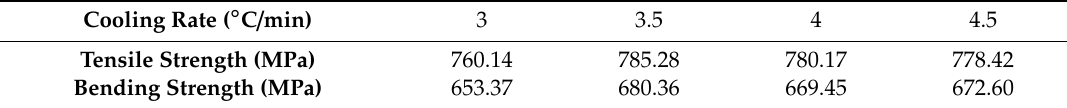
Table 10. E ff ects of cooling rate on mechanical performance. Table 10. Effects of cooling rate on mechanical performance.